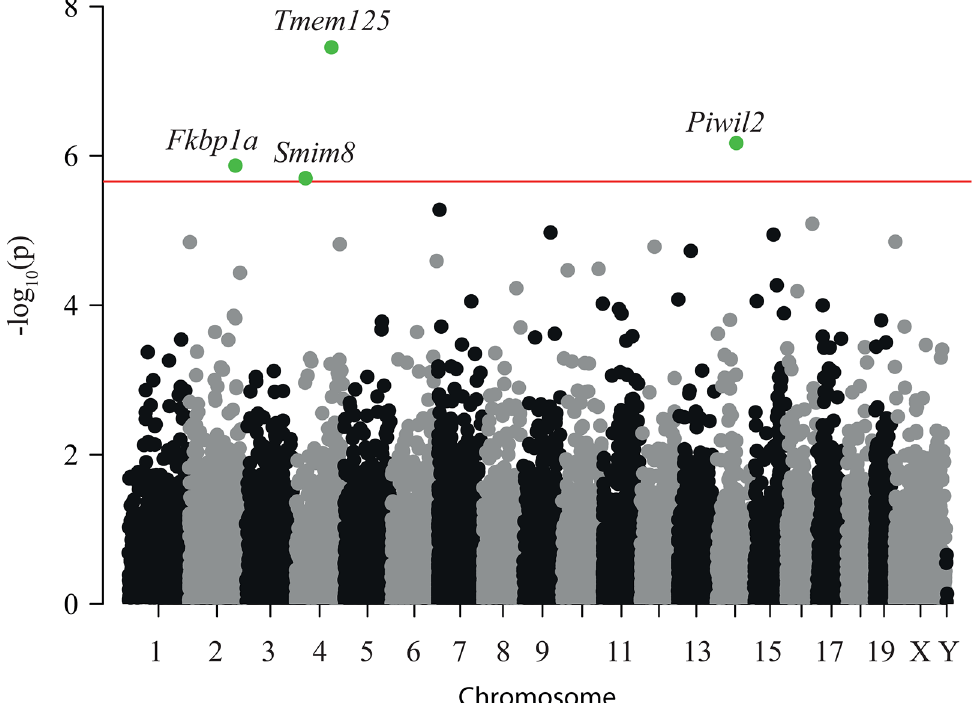
Fig 4. Strain-specific DEHP-induced DMRs. The Manhattan plot shows the statistical significance in minus log10 on the y axis, and the location of the probes in the genome with alternate gray and black colors in respect to the chromosomes locations on the x-axis. Horizontal red line correspond to the threshold for statistical significance settled as p = 0.05 corrected with the number of tested probes (yielding p < 2.2 * 10 − 6 ). The name of the gene is given and the point appears green in case of genome-wide statistical significance. 5 individuals were tested in the four groups (FVB and C57BL/6J background with both control and DEHP300